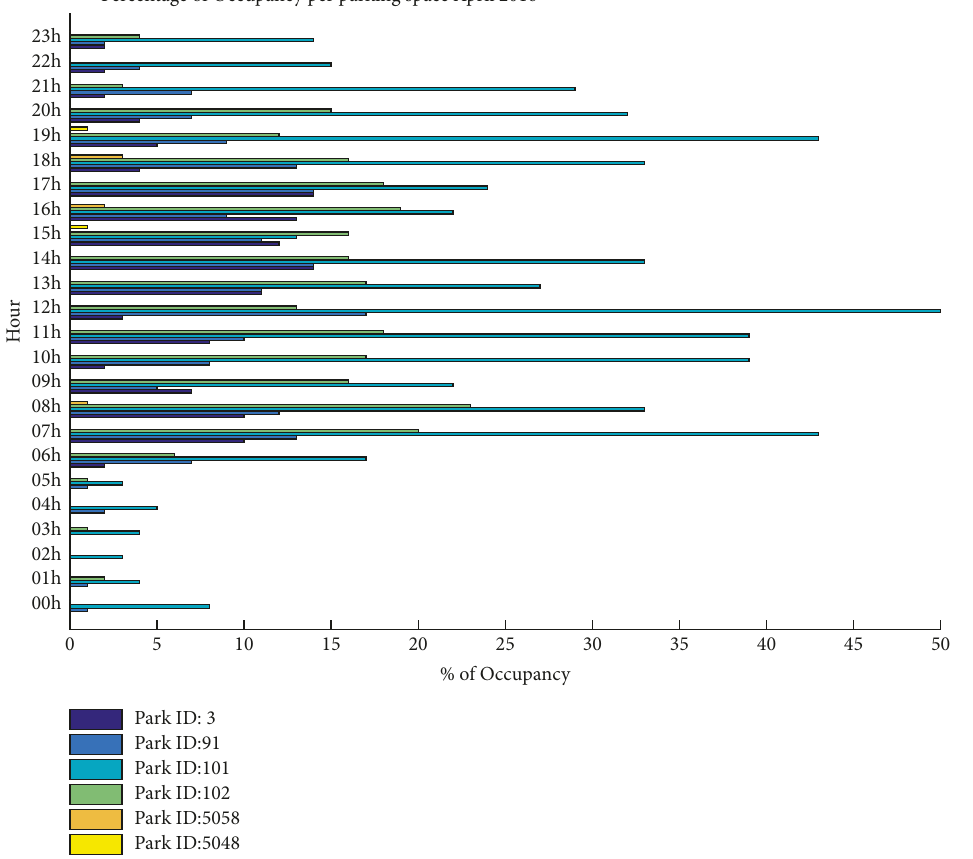
Figure 14: Average parking occupancy in a day of indoor